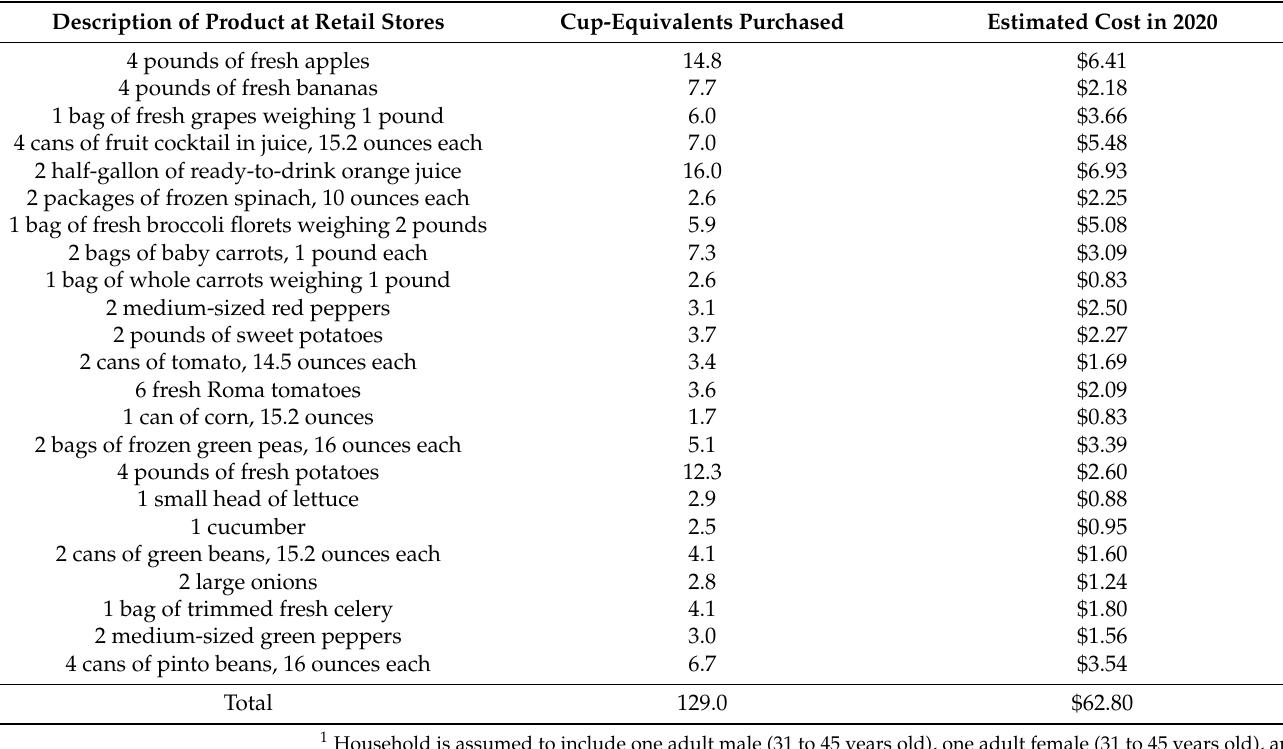
Table 4. Example of a weekly fruit and vegetable basket affordable with a 4-person family’s maximum SNAP benefits based on the Thrifty Food Plan prior to October 2021 1